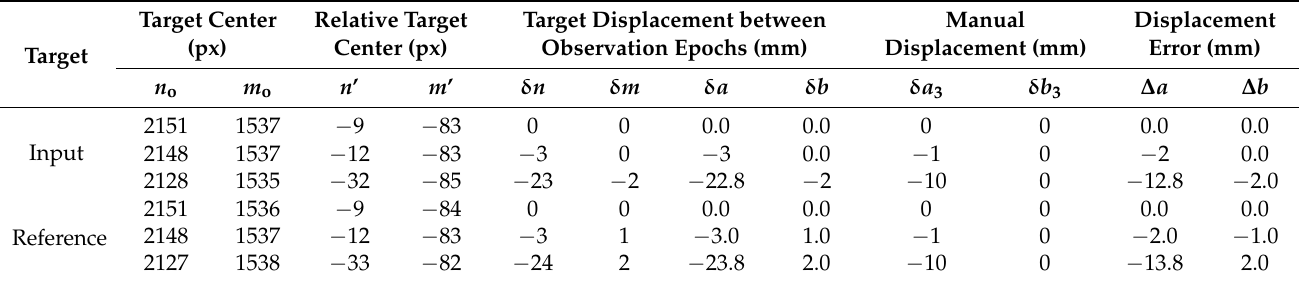
Table 6. Displacement determination for QR target at distance S = 17